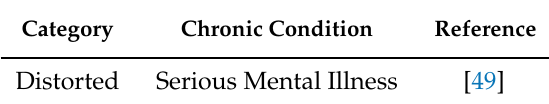
Table 10. Distorted category chosen